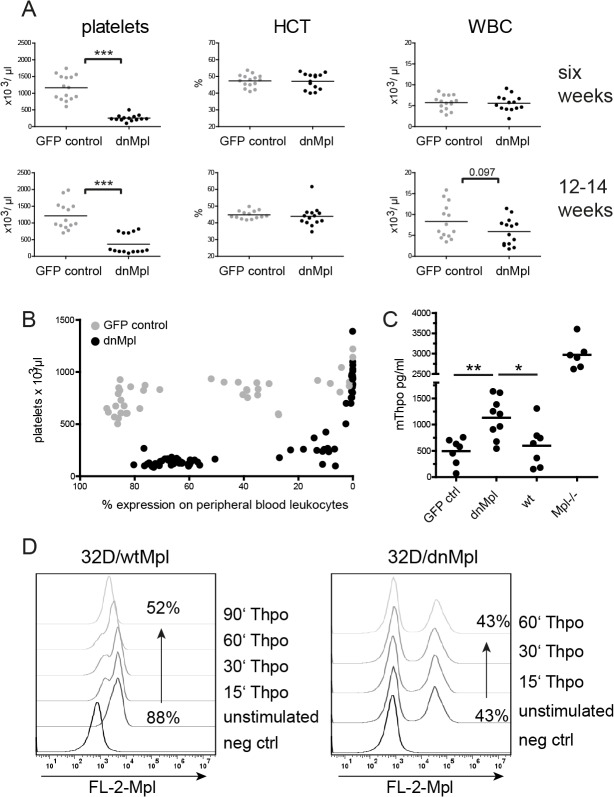
dnMpl expression in vivo causes thrombocytopenia.(A) Blood cell counts of transplanted mice six and 12–14 weeks after transplantation. Platelet counts remained significantly reduced in the dnMpl group, whereas, the hematocrit was unchanged in both groups. Slightly reduced WBC counts were observed at late time points after transplantation in the dnMpl group. (*** p<0.005, Students t-test) HCT: hematocrit, WBC: white blood cells. (B) Correlation of dnMpl expression on leukocytes with platelet counts. Blood of mice transplanted with dnMpl or GFP control transduced BM cells was taken at different time points after transplantation, platelet counts and transgene expression were measured by automated blood cell counts or flow cytometry, respectively. dnMpl expression results in decreased platelet counts. With declining dnMpl expression the platelet counts adjust to physiological levels. (C) Thpo plasma levels were determined in the blood of transplanted mice by ELISA, 12 weeks after transplantation or untransplanted wildtype and Mpl-/- mice. (*p<0.05, **p<0.01, Students t-test). (D) Receptor uptake in 32D cells. 32D cells were transduced with either wtMpl or dnMpl expressing vectors and stimulated with 50ng/mL mThpo or not. Cells were then fixed at different time points after Thpo has been added and surface expression of either receptor was measured by flow cytometry using an anti-HA Biotin conjugated primary and Streptavidin-PE secondary antibody.